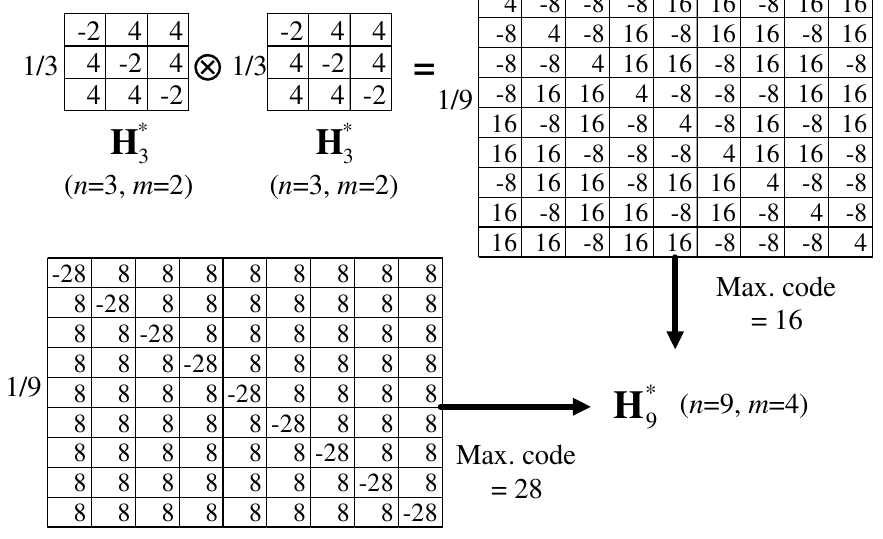
Figure 5. Expansion of an M-H matrix using Kronecker